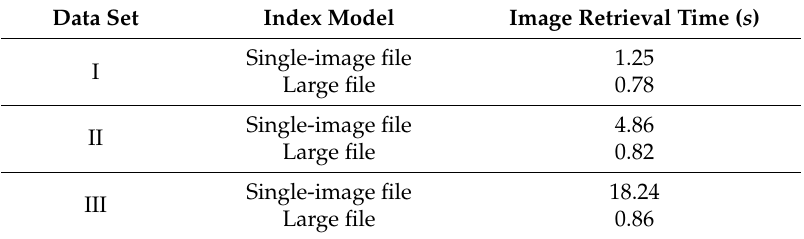
Table 3. Comparison of image retrieval times in the large file model and the single-image file